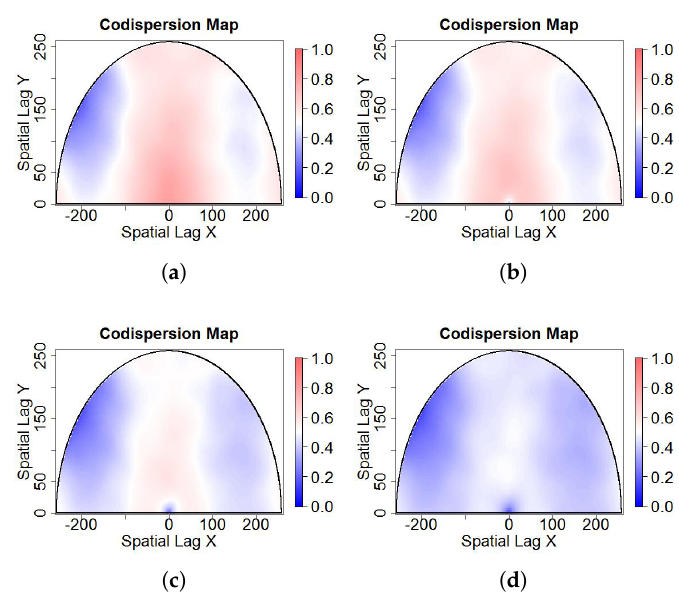
Figure 8. Images ( a – d ) are the corresponding codispersion maps between Figure 2a and the contaminated Figure